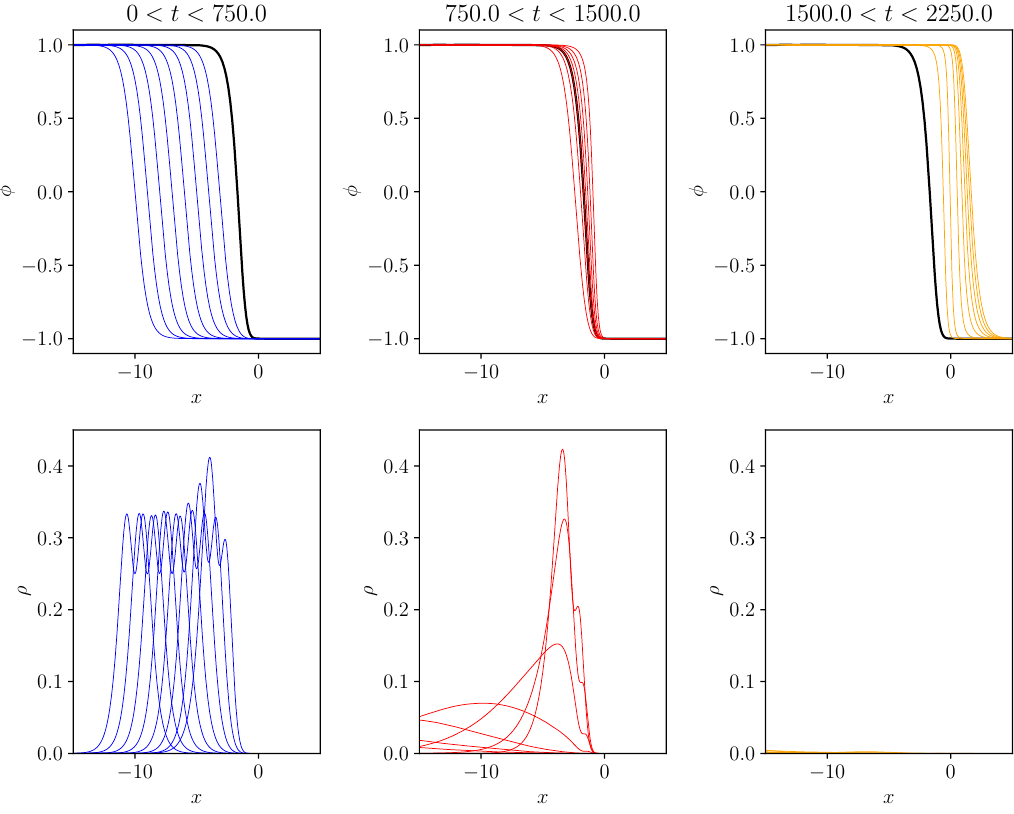
Figure 6 . Several snapshots of the scalar field φ and fermion number density ρ as the antikink approaches the spectral wall. The antikink crosses the wall for β = 46 . 0